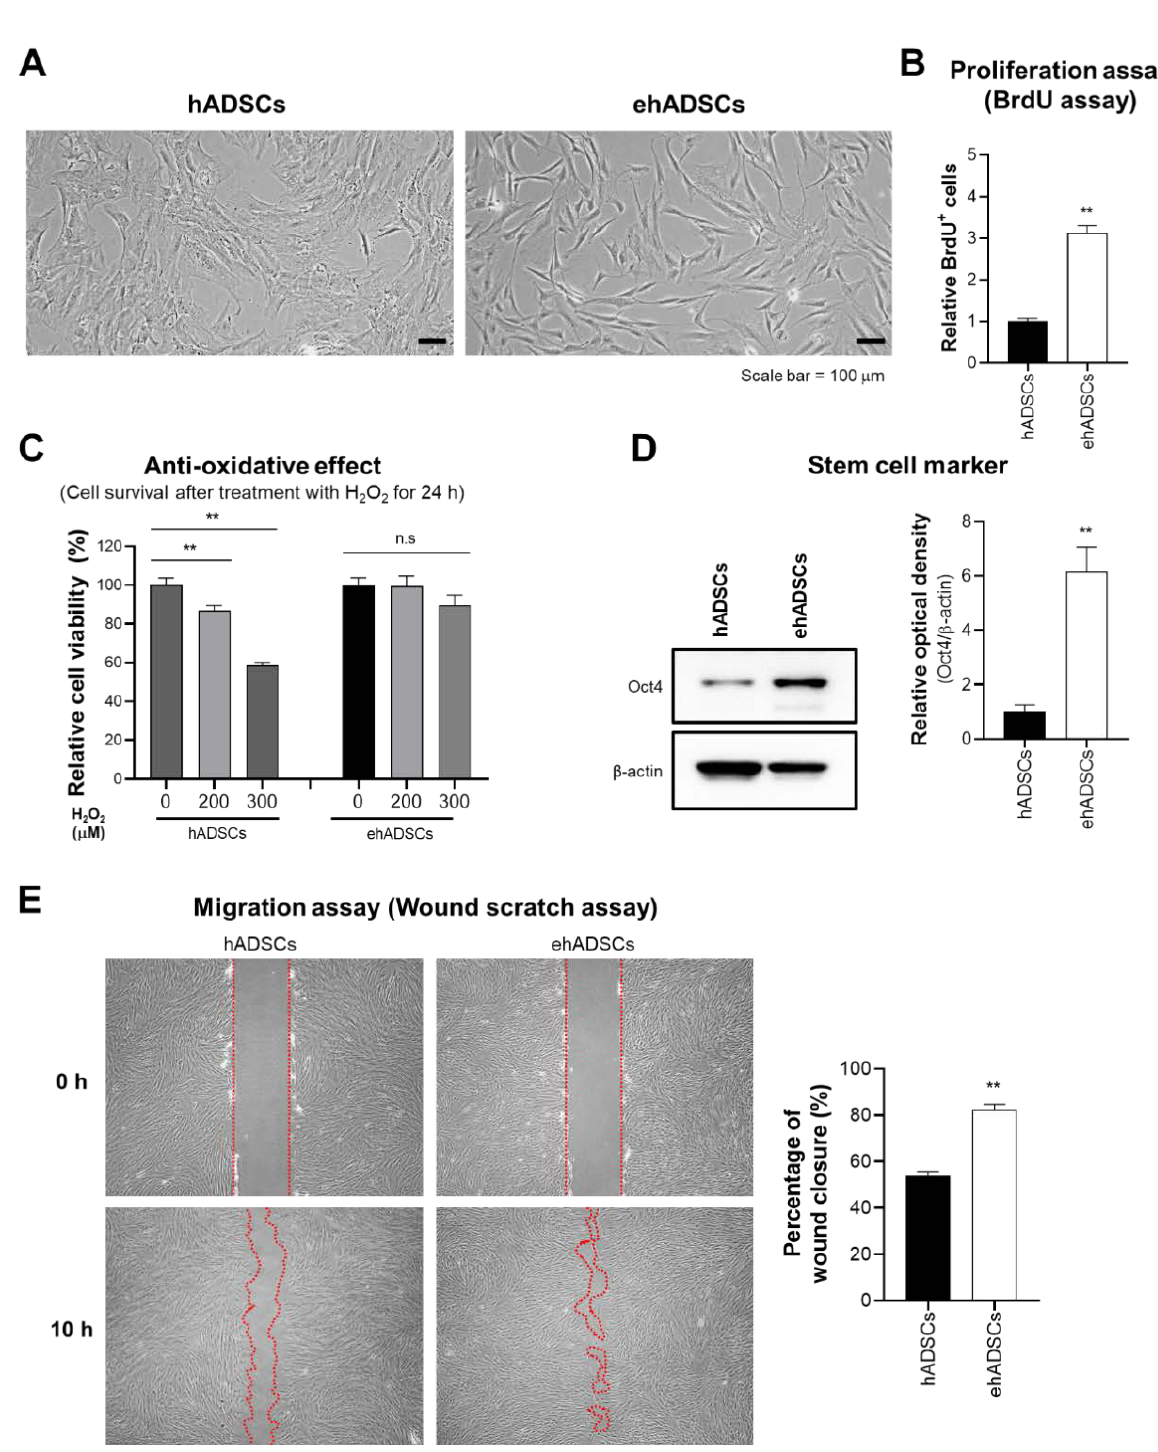
Figure 2. Characteristics and functionalities of enhanced hADSCs (ehADSCs). ( A ) Morphologies of hADSCs and ehADSCs. ( B ) ehADSCs showed greater proliferation, compared with hADSCs. ( C ) ehADSCs tolerated oxidative stress better than hADSCs. ( D ) ehADSCs showed more stem cell characteristics, compared with hADSCs. ( E ) Red mark area indicates the area of scratched wound site. Migration of ehADSCs and hADSCs. ehADSC mobility was significantly greater, compared with hADSC mobility. Values are means ± standard errors of the mean (** p < 0.01; n.s., not significant).